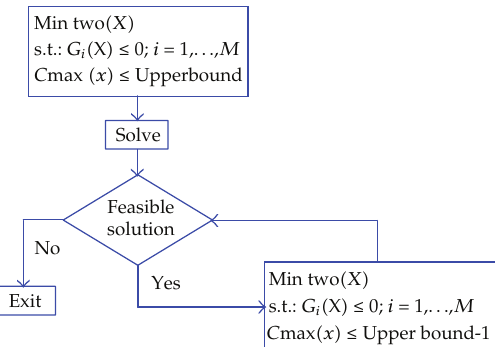
Figure 1: Flow diagram of the solving